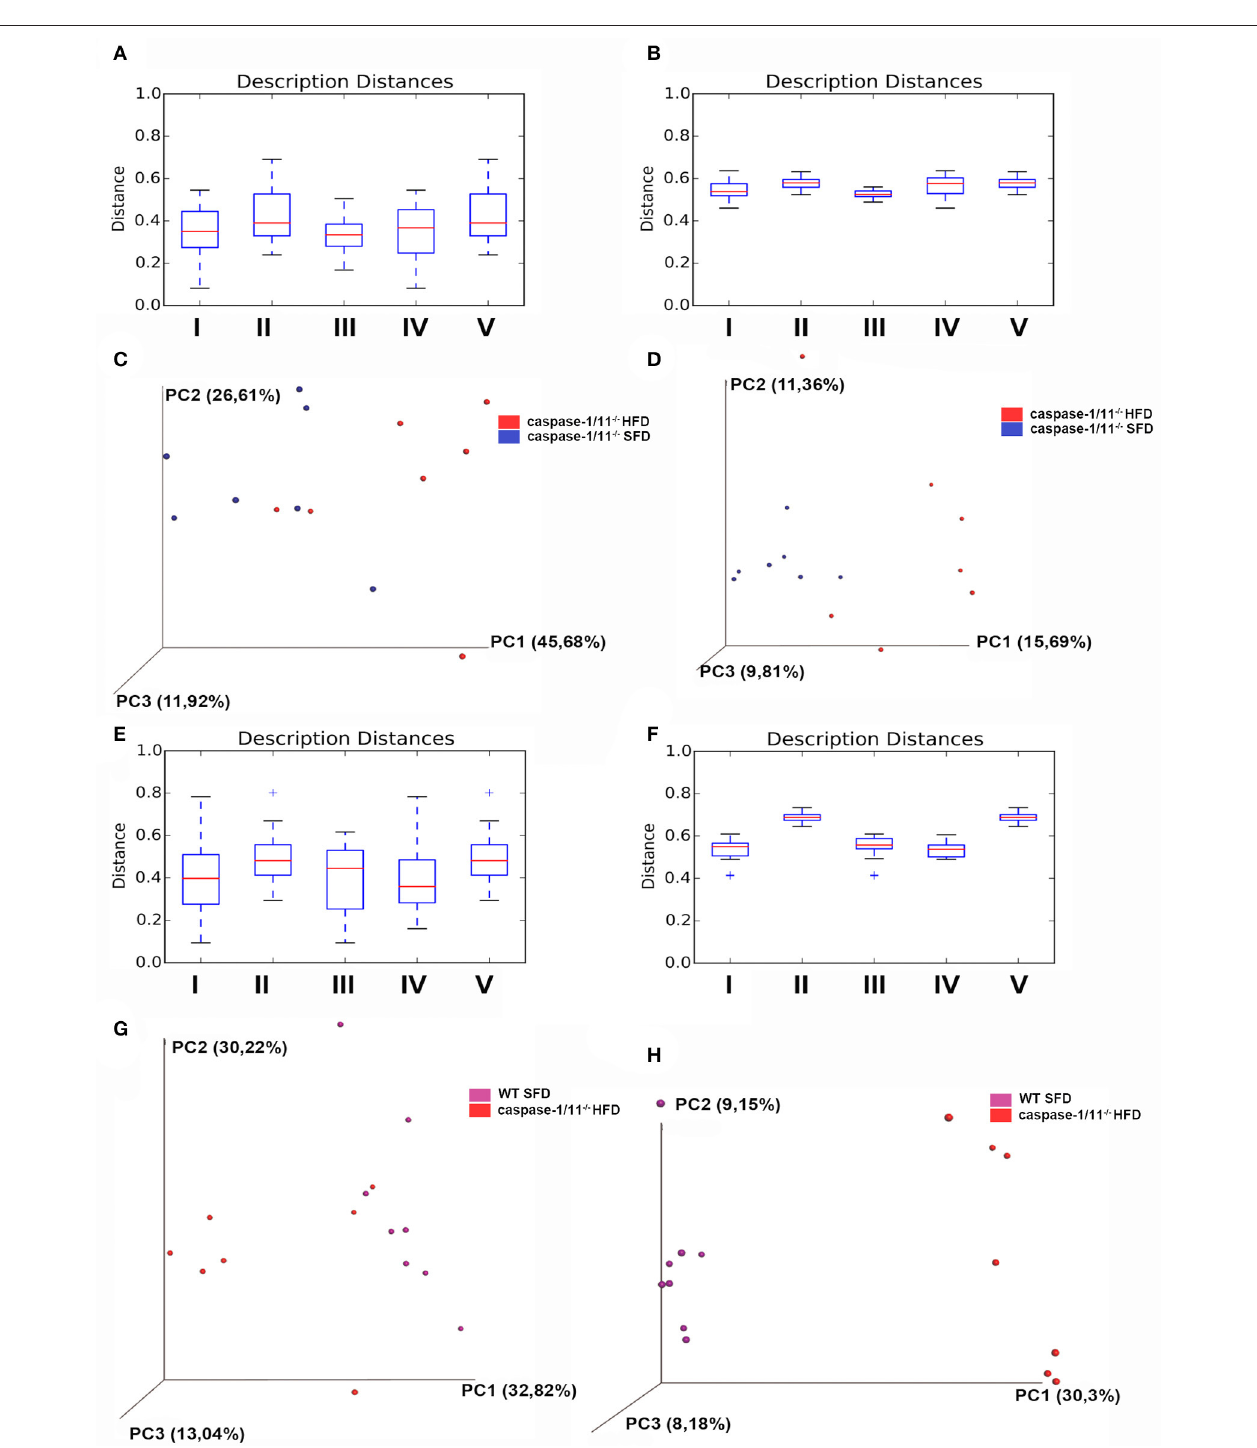
FIGURE 4 | β -diversity of gut microbiota. Distance boxplots weighted_unifrac (A) and unweighted unifrac (B) : I—All within the description, II—All between description, III— caspase-1/11 − / − SFD vs. caspase-1/11 − / − SFD, IV— caspase-1/11 − / − HFD vs. caspase-1/11 − / − HFD, and V— caspase-1/11 − / − SFD vs. caspase-1/11 − / − HFD. (C) PCoA plot weighted_unifrac and (D) PCoA plot unweighted_unifrac, blue: caspase-1/11 − / − SFD, red: caspase-1/11 − / − HFD. Distance boxplots weighted_unifrac (E) and unweighted unifrac (F) : I—All within the description, II—All between description, III— caspase-1/11 − / − HFD vs. caspase-1/11 − / − HFD, IV—WT HFD vs. WT HFD, and V— caspase-1/11 − / − HFD vs. WT HFD. (G) PCoA plot weighted_unifrac and (H) PCoA plot unweighted_unifrac, purple: WT HFD, red: caspase-1/11 − / − HFD. The tests of significance were performed using a two-sided Student’s two-sample t test, the non-parametric p -values were calculated